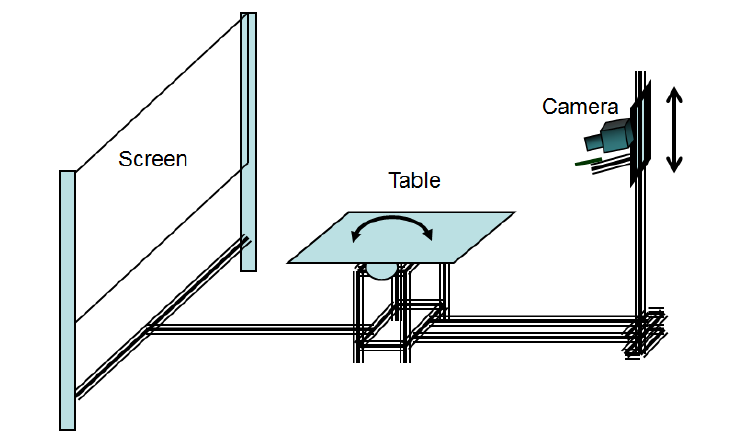
Figure 2. Image acquisition